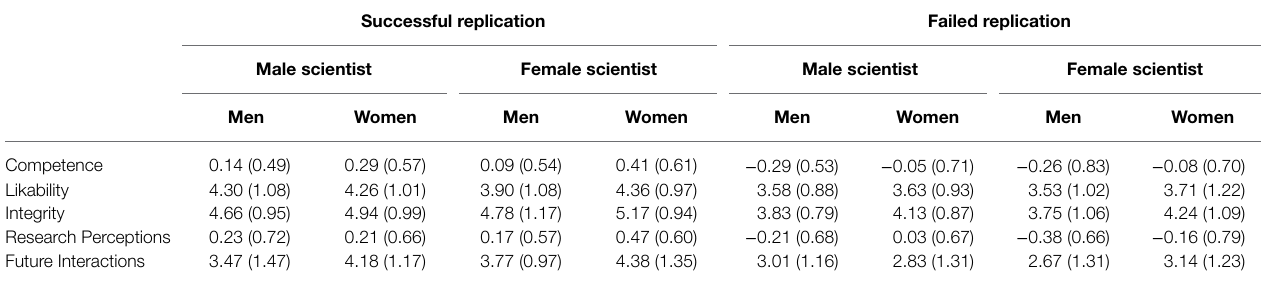
TABLE 4 | Study 2 dependent variable means and standard deviations by experimental conditions and participant gender. Successful